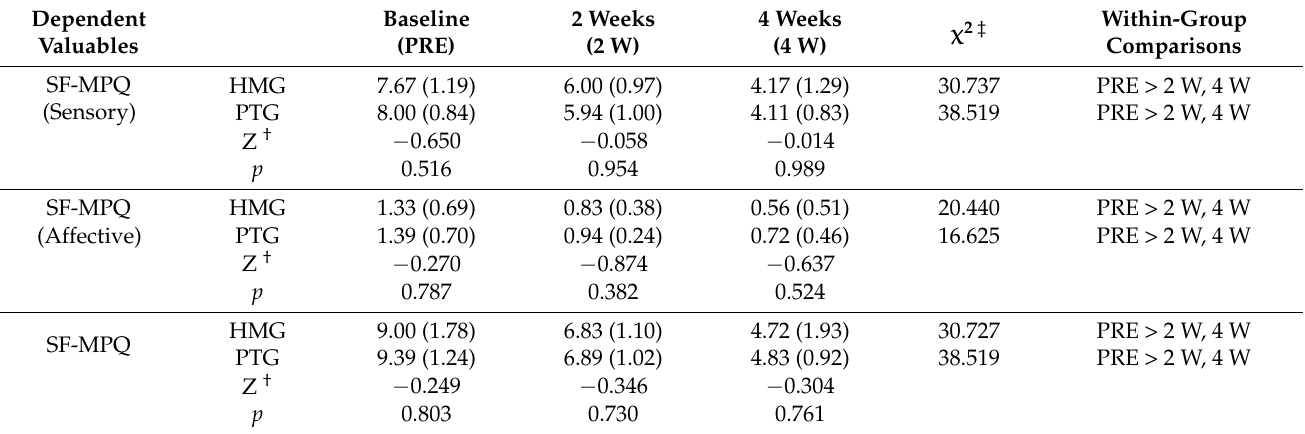
Table 5. Comparison of the SF-MPQ